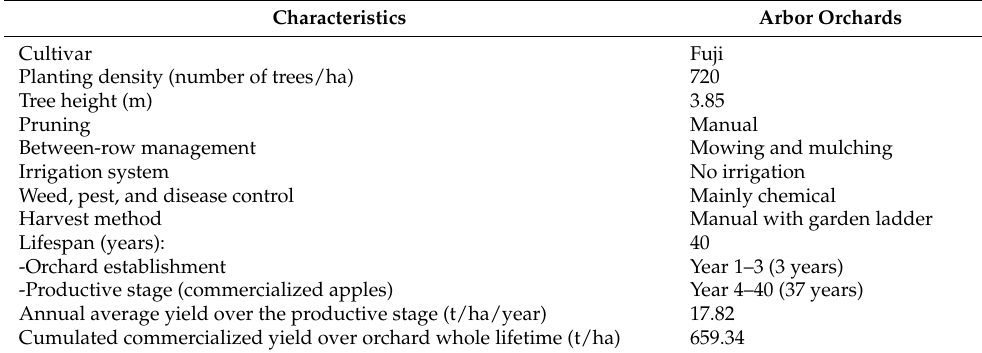
Table 1. Apple production inputs in Baishui County of Shaanxi Province in